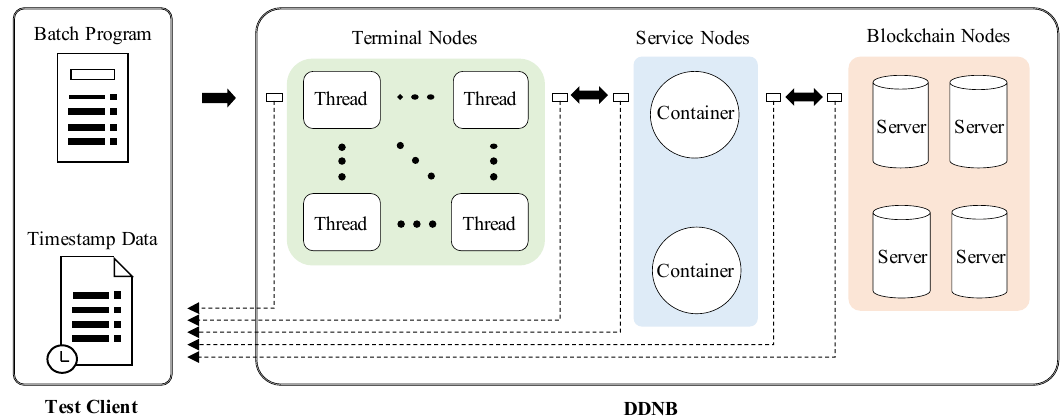
Figure 6. Test flow: Test client runs a batch program that executes a predefined transaction and records UNIX timestamps of every moment when packets are transmitted and received between